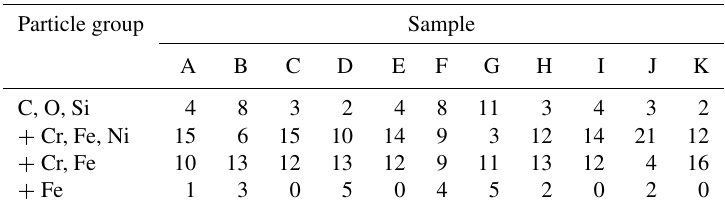
Figure 5. STEM image (upper left) and element distribution images of a refractory carbonaceous particle from sample C (19.8km altitude). Table 3. Absolute number of refractory particles as a function of particle